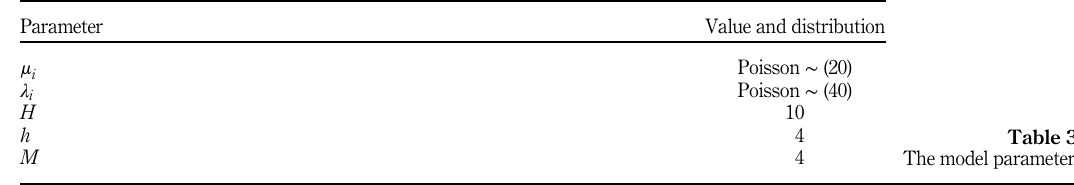
Table 3. The model parameters